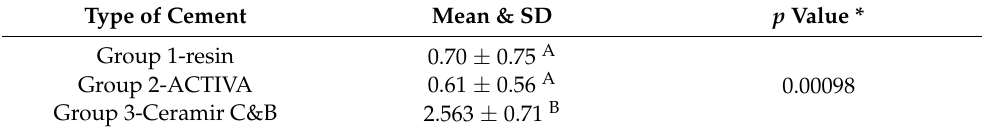
Table 2. Mean and standard deviation values for microleakage among different cement groups.